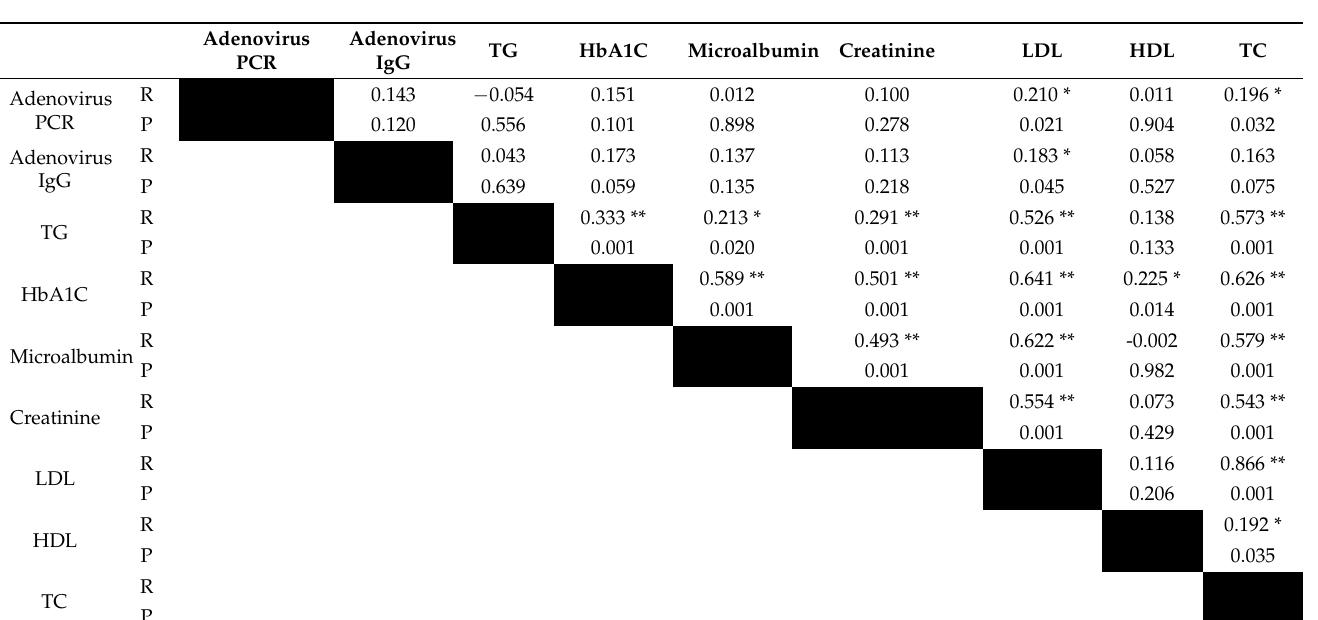
Table 2. Correlation between the existence of adenovirus DNA and anti-IgG and biochemical